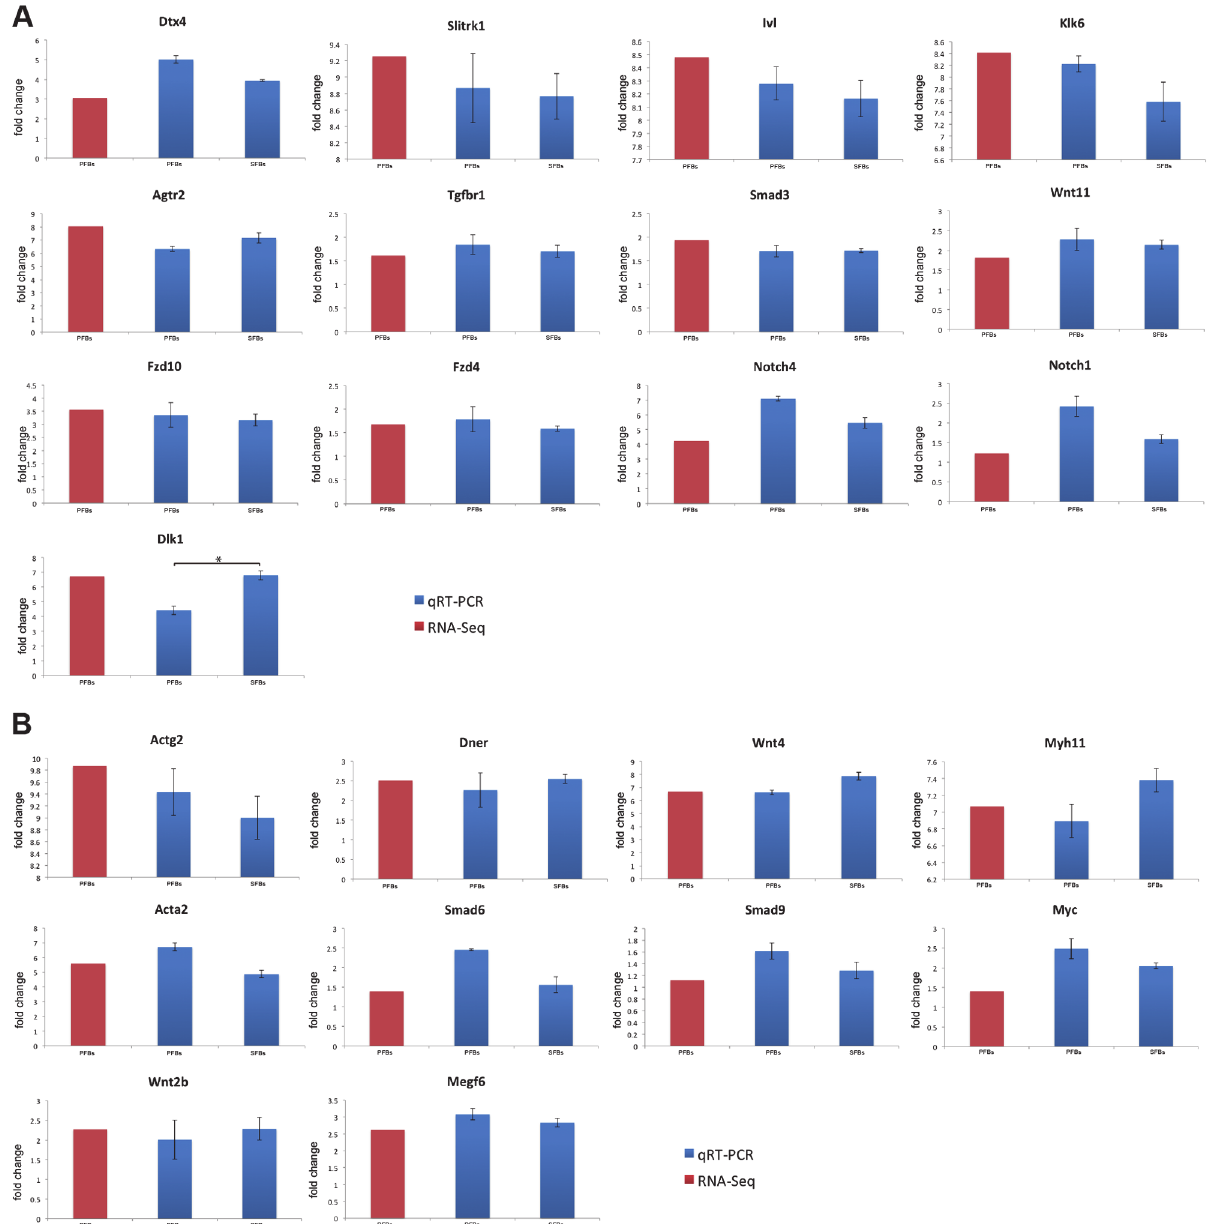
Fig 7. Validation of RNA-Seq results and comparison of gene expression between SFBs and PFBs by qRT-PCR. (A) Down-regulated genes.(B) Up- regulated genes. Fold changes shown are((SFBs or PFBs gene expression level)/(SKPs gene expression level)). Error bars represent SE; * represents statistically